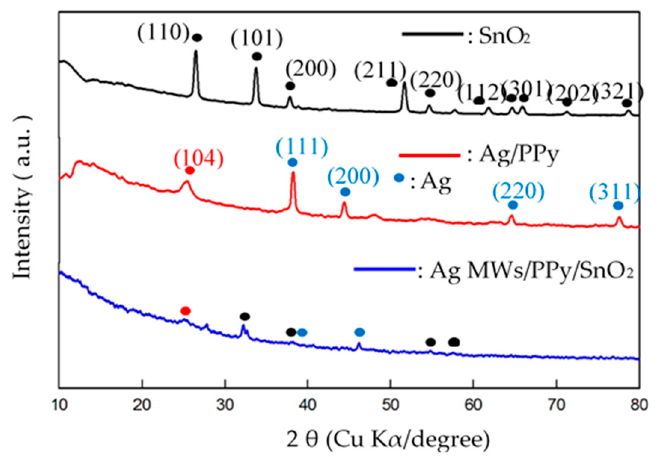
Figure 2. XRD patterns of pristine SnO 2 , standalone Ag/PPy, and Ag MWs/PPy/SnO 2 ternary composite that was fabricated using one-step UV-irradiation photopolymerization technique.